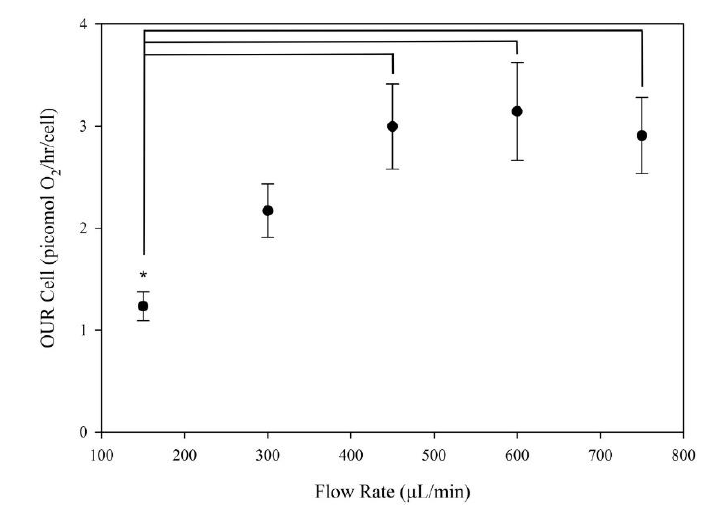
Figure 3. Oxygen uptake rate (OUR). * p < 0.05.